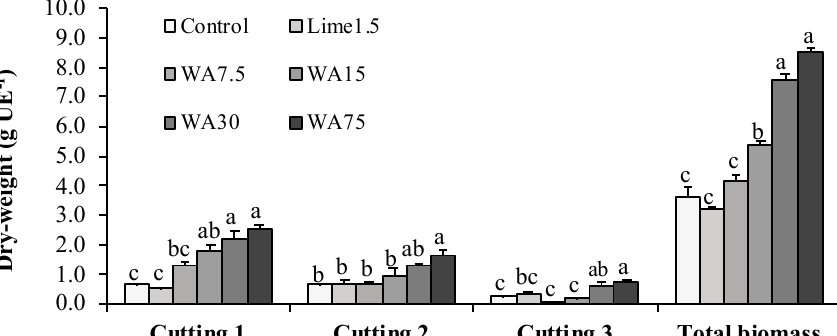
Figure 2. Dry weight of ryegrass ( Lolium perenne L.). Cuttings 1, 2, and 3 were taken at days 40, 70, and 100 post-seeding, respectively. The total biomass includes the three cuttings plus the residual mass. Lime1.5, commercial lime at 1.5 g kg − 1 ; WA7.5, WA15, WA30, and WA75, wood ash at 7.5, 15, 30, and 75 g kg − 1 , respectively. EU, experimental unit. Bars indicate standard error of the mean (n = 3). Means with different letters (a, b, c, d) differ significantly (Tukey’s test, p ≤ 0.05). In the aerial shoot part of the plant, N, P, and K contents significantly increased following the application of WA (Figure 3). For N and K, significant differences were registered from the 15 g kg − 1 WA, while P increased significantly from 7.5 g kg − 1 WA.